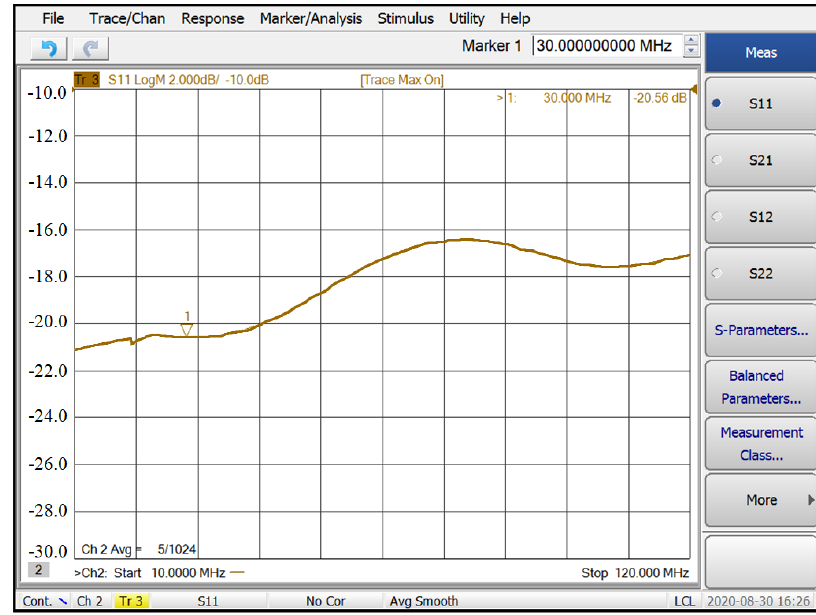
Figure 17. The measured S 11 of the front-end.